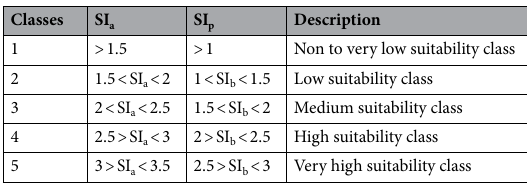
Table 12. Ranges and classes of suitability index